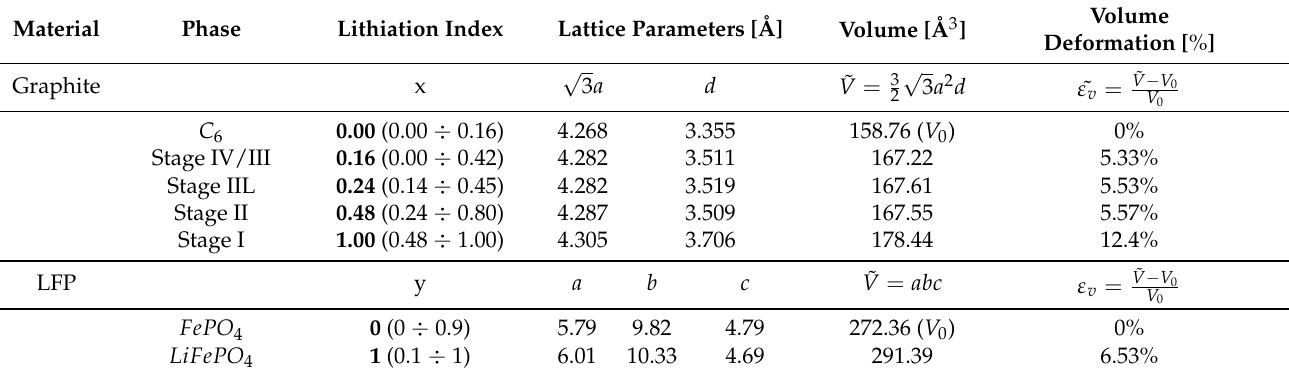
Table 1. Lattice parameter of graphite [33] and LFP [39]. In the lithiation index column, the bold number refers to the maximum composition of that phase, and interval refers to the range where that phase exists. Volume deformation ˜ ε v is referred to as the single